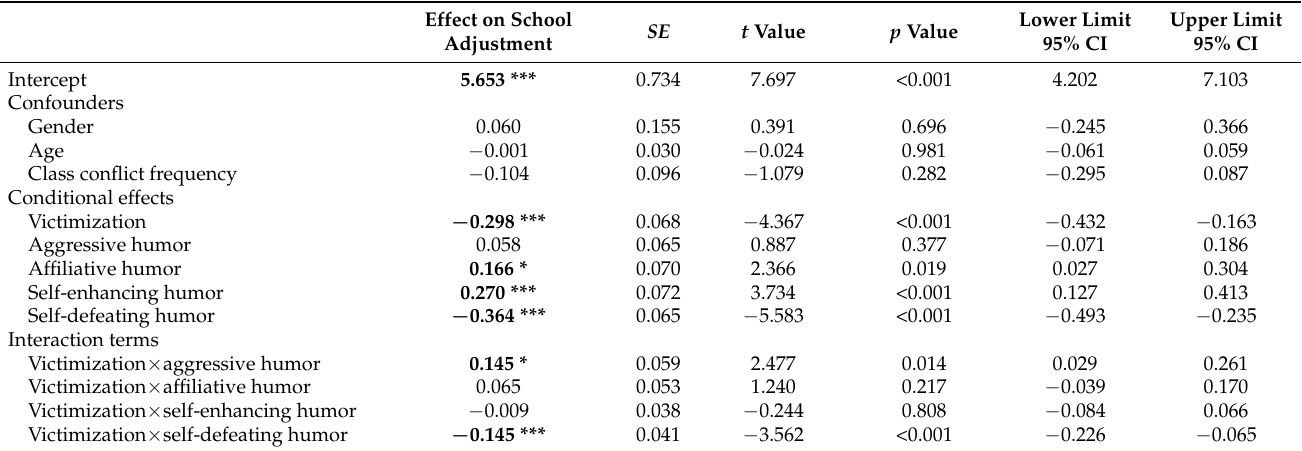
Table 3. The effect of victimization on school adjustment moderated by humor styles while controlling for gender, age and class conflict frequency. Effect on School Adjustment